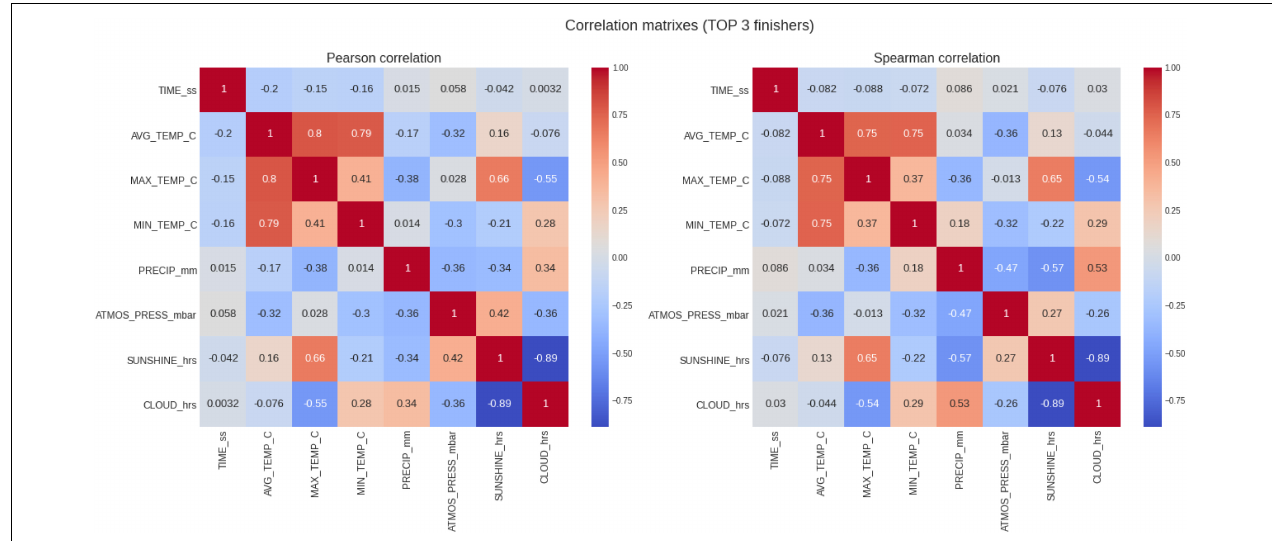
FIGURE 4 | Analysis of the correlation of the target variable (marathon race time) and the descriptive variables (weather conditions) for the top three runners. PRECIP, precipitation in mm, SUNSHINE duration in hours, CLOUD cover in hours; ATMOS_PRESS, atmospheric pressure in mbar; AVG_TEMP, average temperature in degrees Celsius; MAX_TEMP, maximum temperature in degrees Celsius; MN_TEMP, minimum temperature in degrees